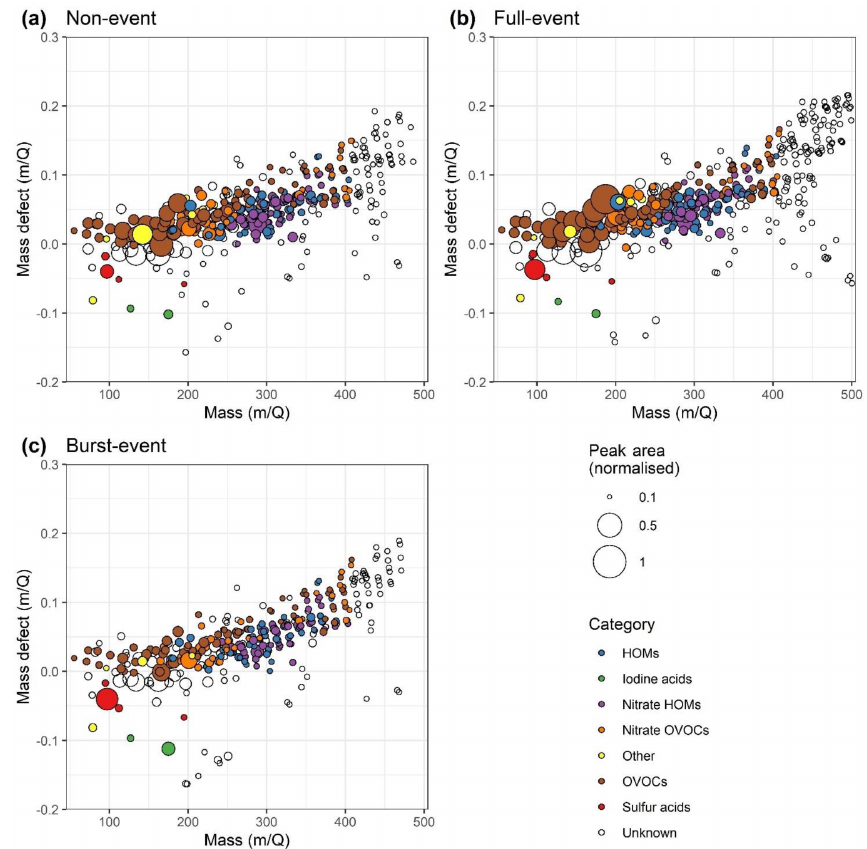
Figure 9. Mass-defect plots for (a) non-event, (b) full-event, and (c) burst-event periods; data taken from 10:00 to 15:00 on the days 11, 16 and 15 July 2018 respectively. Size corresponds to mass spectral peak area. Ions are coloured according to identified chemical composition. Blue points correspond to HOMs containing all organic species with ≥ 5 carbon atoms and ≥ 6 oxygen atoms and an O:C ratio of > 0 . 6. Purple points correspond to the same but for species containing one to two nitrogen atoms. Species not meeting this HOM criterion were classed generally as OVOCs which are coloured brown , with the nitrogen-containing OVOCs coloured orange . Sulfur acids ( red ) include as well as the sulfuric acid dimer. Iodine acids ( green ) contain both IO − ions HSO − , CH 3 SO − and SO − 4 3 5 deprotonated hydrogen iodide). Unidentified points are left